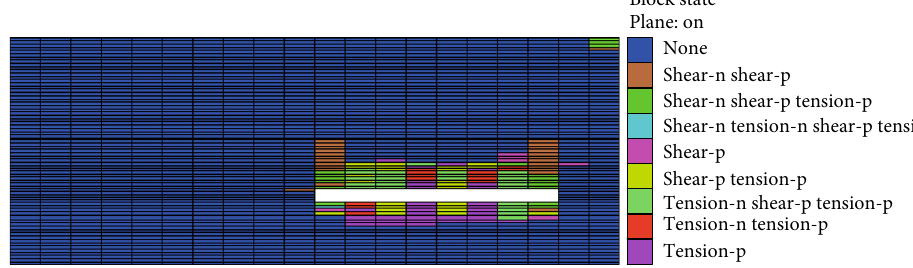
Figure 4: Model unit failure state when mining 80m.